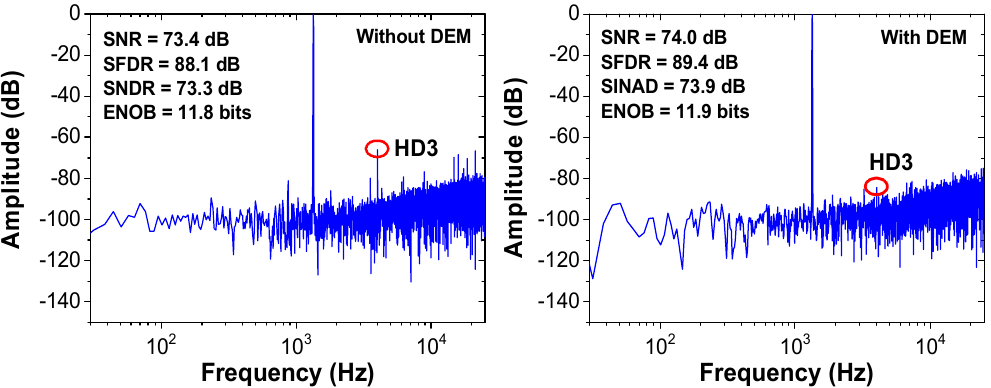
Figure 18. Comparison of the dynamic performance with and without the DEM.